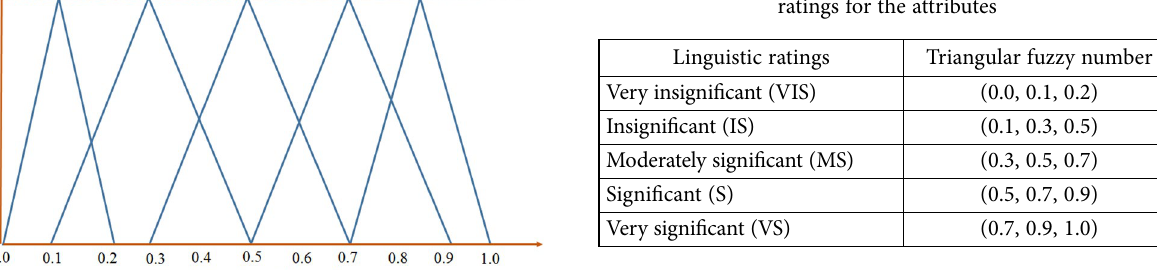
Figure 4. Hierarchy structure for evaluating the negative impacts of rural road construction Table 3. Fuzzy numbers defining linguistic